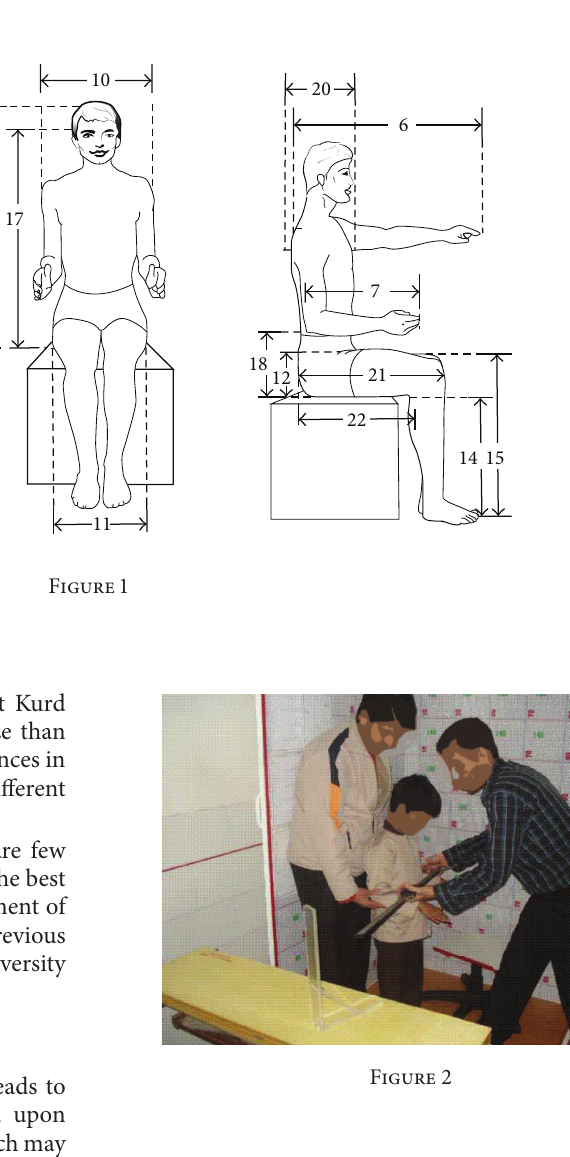
length, forearm length, forearm-forearm distance, elbow- elbow distance, shoulder width, buttock width, buttock- knee length, and buttock-popliteal length), depths (chest and abdomen), and thicknesses (one-thigh and two-thigh)